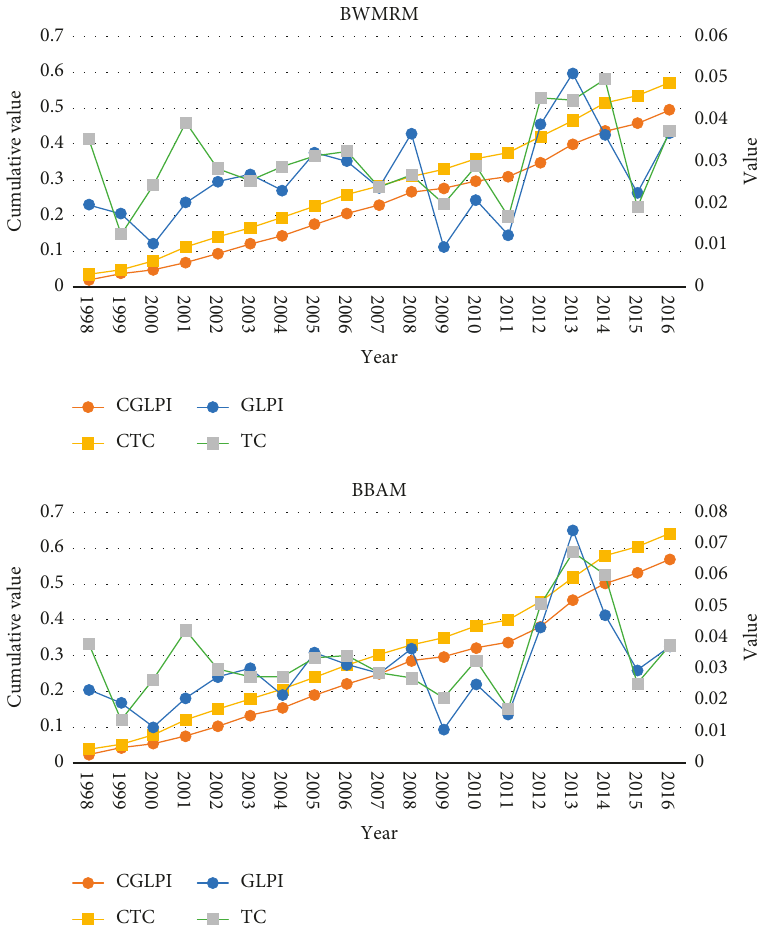
Figure 1: The dynamic change of AGTFP growth in China.